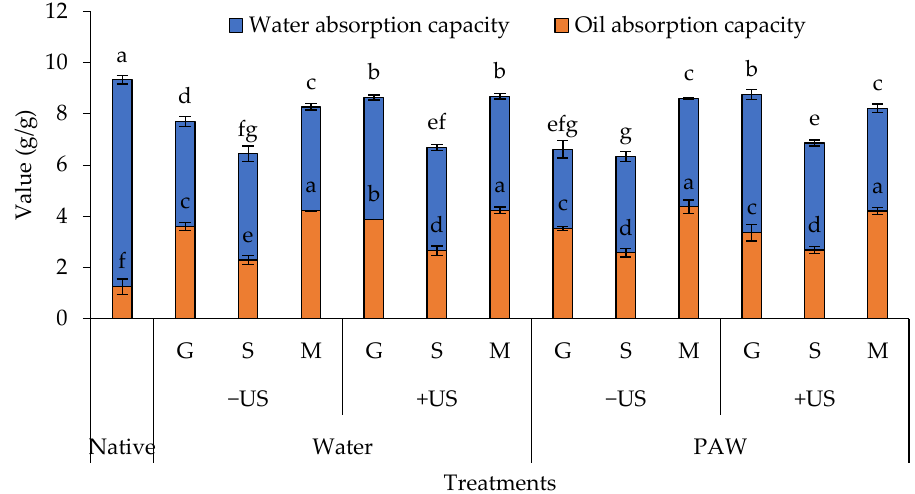
Figure 7. Water absorption capacity (WAC) and oil absorption capacity (OAC) of rice starch–phenolic complexes. Different phenolic compounds—gallic acid (G), sinapic acid (S), and crude Mon-pu ( Glochidion wallichianum Muell Arg) (M) extract—were complexed with hydrothermally pre-gelatinized rice starch prepared using distilled water (Water) or plasma-activated water (PAW) without ( − US) and with (+US) the aid of ultrasonication. The native starch (Native) was used to compare. Bars represent the standard deviations from triplicate determinations. Different letters on the bars within the same parameter indicate the significant differences ( p < 0.05).